Question: In a single sentence, describe what this figure presents.
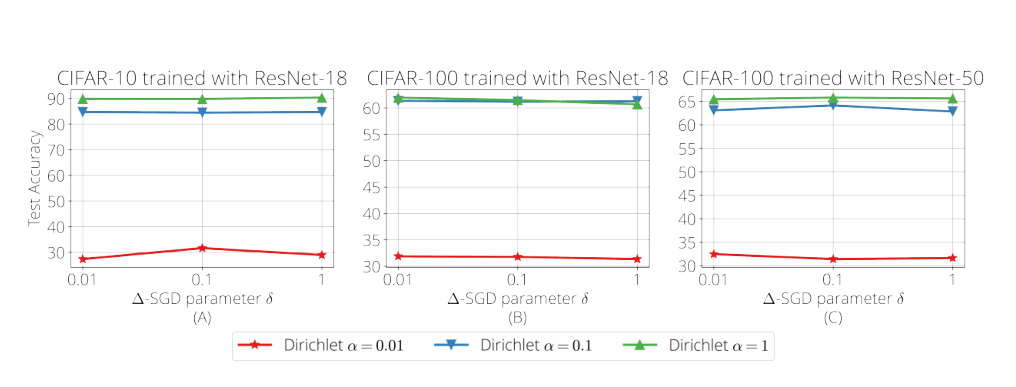
Answer: Effect of using different δ in the second condition of the step size of ∆-SGD.